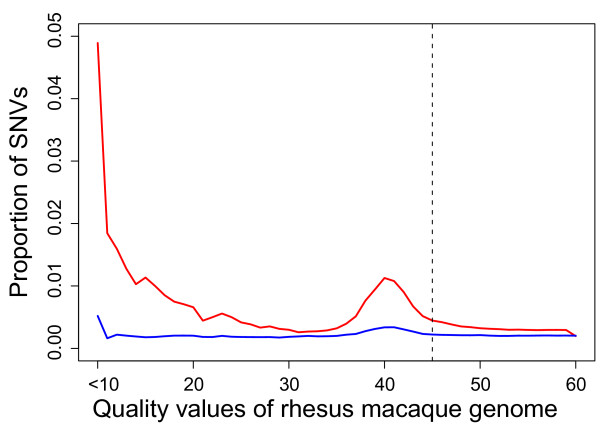
SNV discovery rate and rhesus macaque genome quality. The red and blue lines represent the rates of homozygous and heterozygous SNVs, respectively, with given rhesus macaque genome sequence quality values (QVs). SNVs at sites having QV < 45 (left of the dashed line) were filtered out.